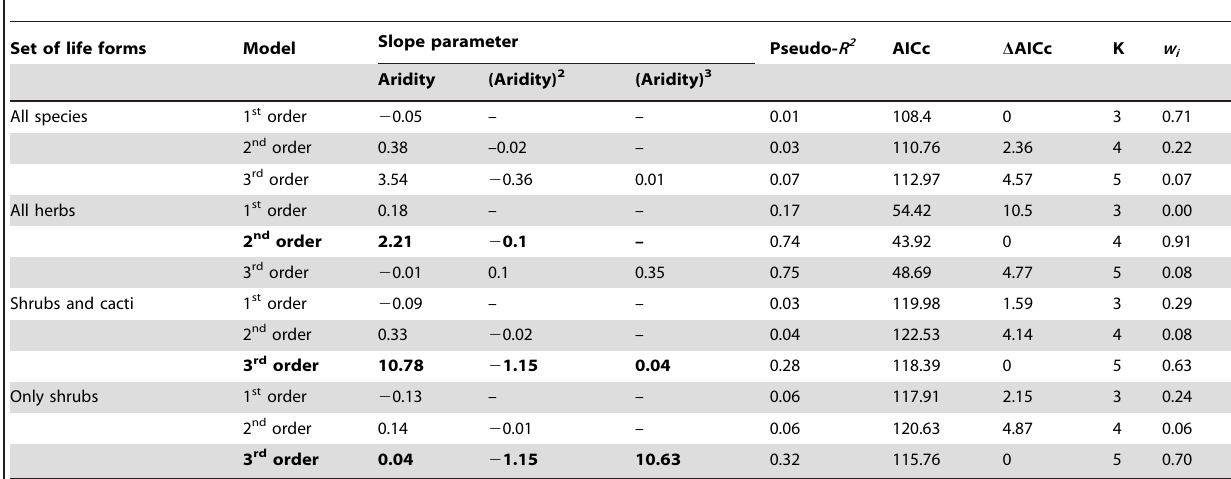
Relationships are shown for all life form sets considered in the study. For each set, linear (1 st order), quadratic (2 nd order) and cubic (3 rd order) models are shown. All models were fitted using general linear models and significance of their parameters estimates are based on Chi-square likelihood ratio tests. Significant coefficient values are shown in bold.